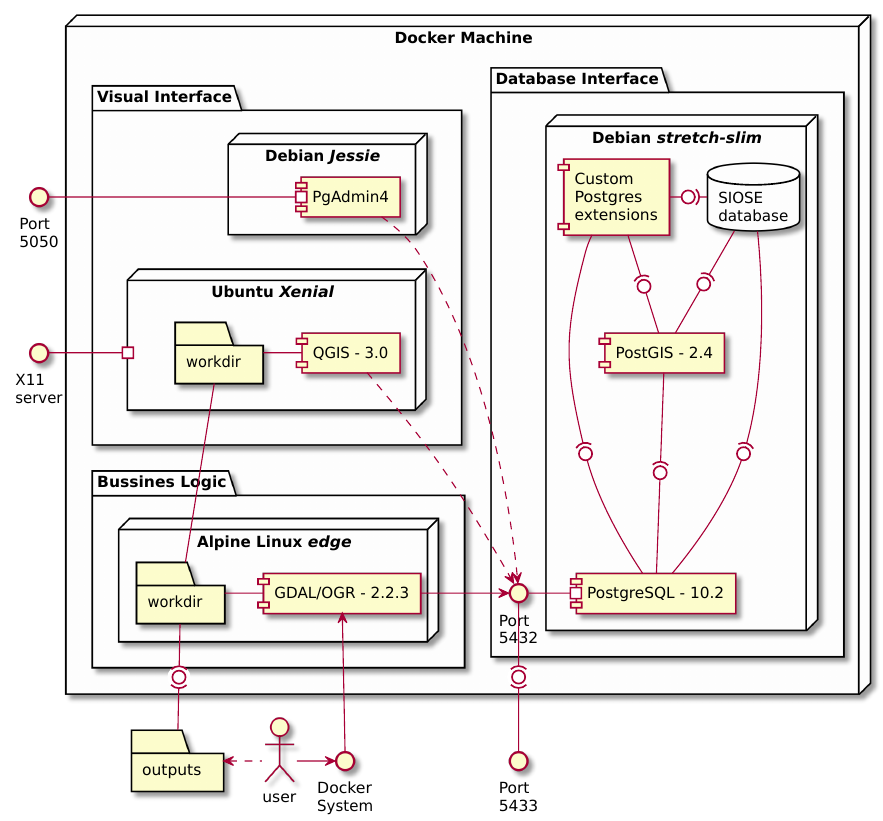
Figure 6. UML components diagram showing the containers and configurations used in the SIOSE-splitter